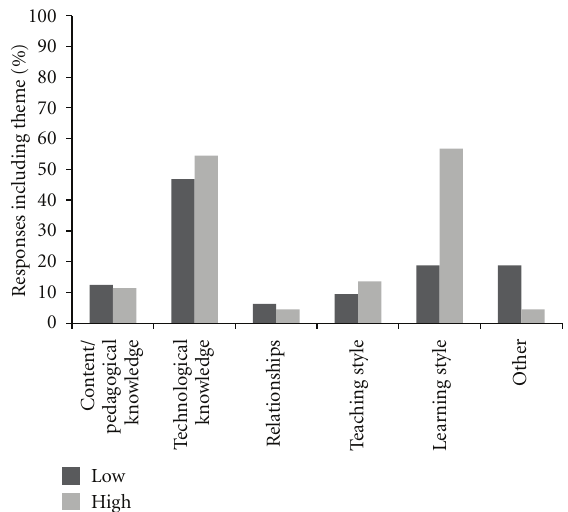
Figure 7: Patterns of themes by integration level for the char- acteristics that make excellent teachers who happen to integrate technology e ff ectively, di ff erent from teachers who do